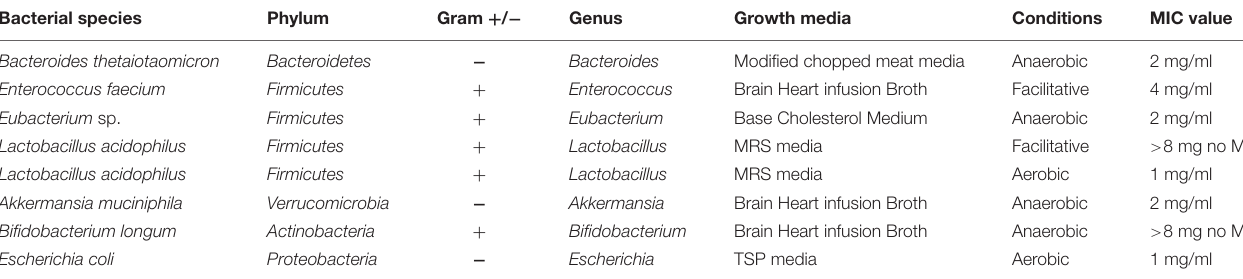
TABLE 1 | Aloin MIC value for intestinal commensal both Gram-positive and Gram-negative bacteria. Bacterial species